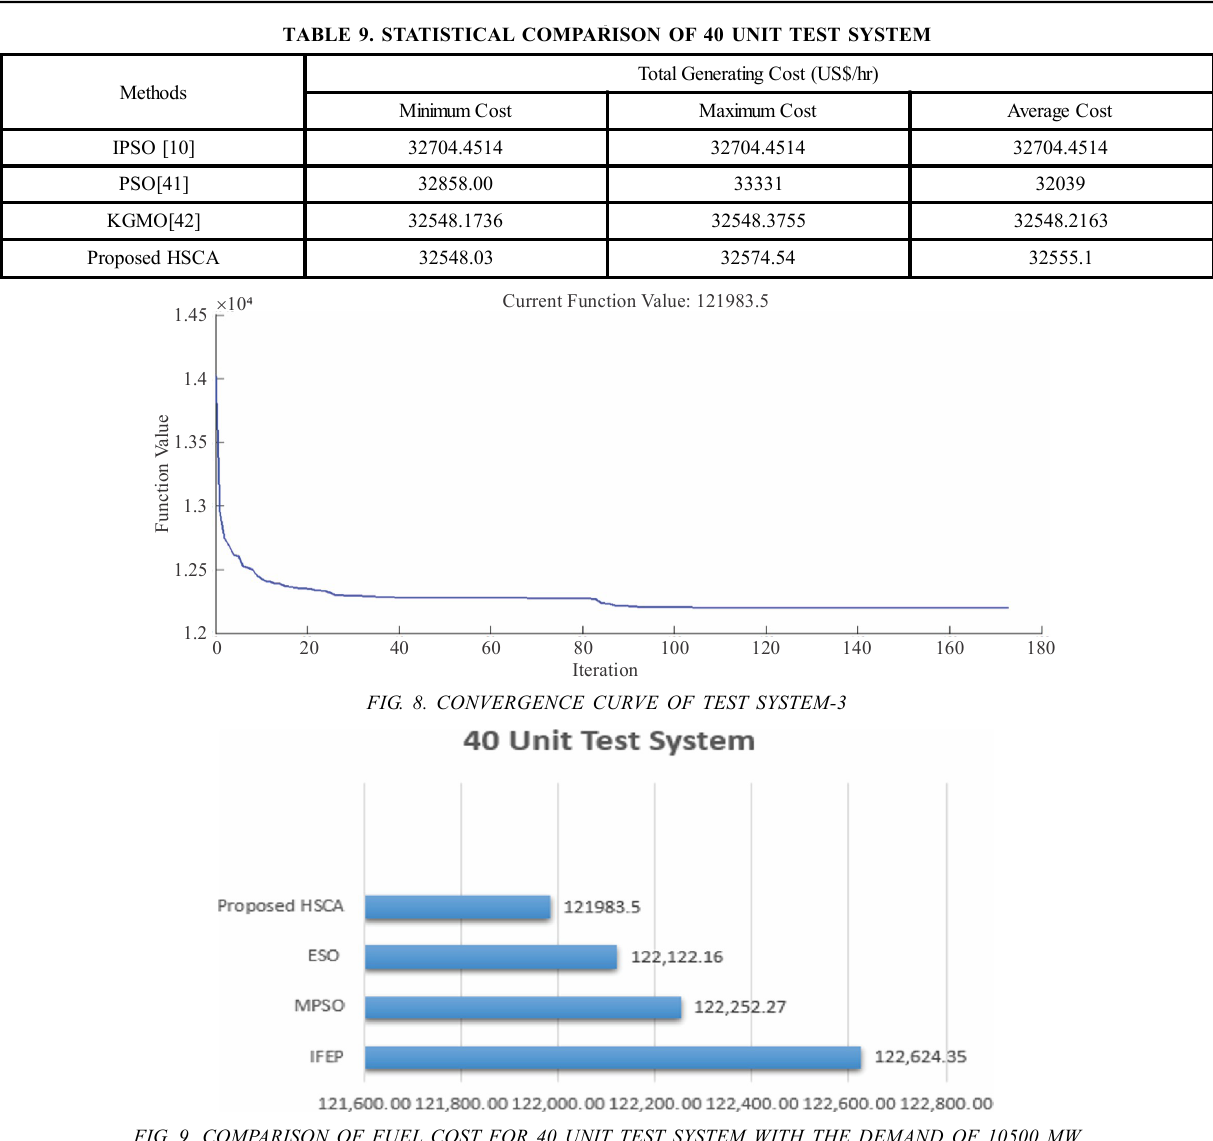
FIG. 9. COMPARISON OF FUEL COST FOR 40 UNIT TEST SYSTEM WITH THE DEMAND OF 10500